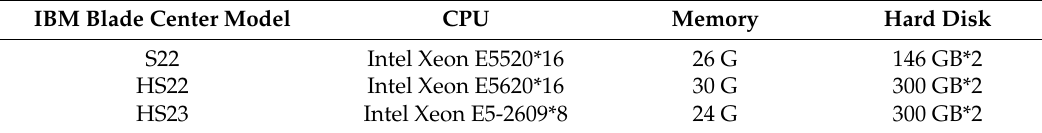
Table 1. Hardware specification.